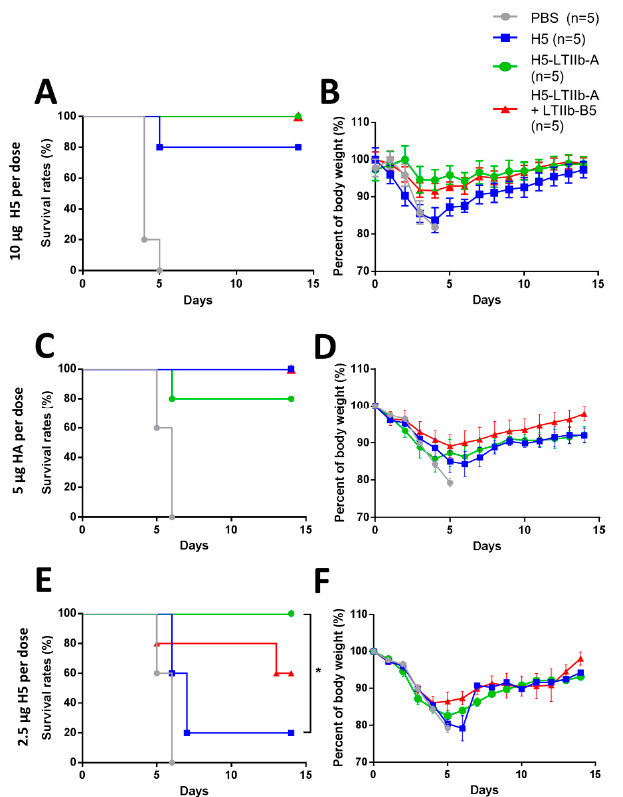
Figure 5. Protection against H5N1 influenza virus infection in mice intranasally immunized with H5-LTIIb-A fusion protein for ( A,C,E ) the survival curves, and for ( B,D,F ) the body weight loss. Groups of BALB / c mice intranasally immunized with PBS, H5 protein (10, 5, or 2.5 µ g per dose), H5-LTIIb-A fusion protein (10, 5, or 2.5 µ g per dose), or the combination of H5-LTIIb-A fusion protein (10, 5, or 2.5 µ g per dose) and 5 µ g of recombinant LTIIb-B5 protein for three-dose regimens. Two weeks after the third immunization, each mouse was intranasally injected with a 20-fold lethal dose of H5N1 virus. Statistical significance was expressed as ** p < 0.01; *** p < 0.001; **** p < 0.0001.